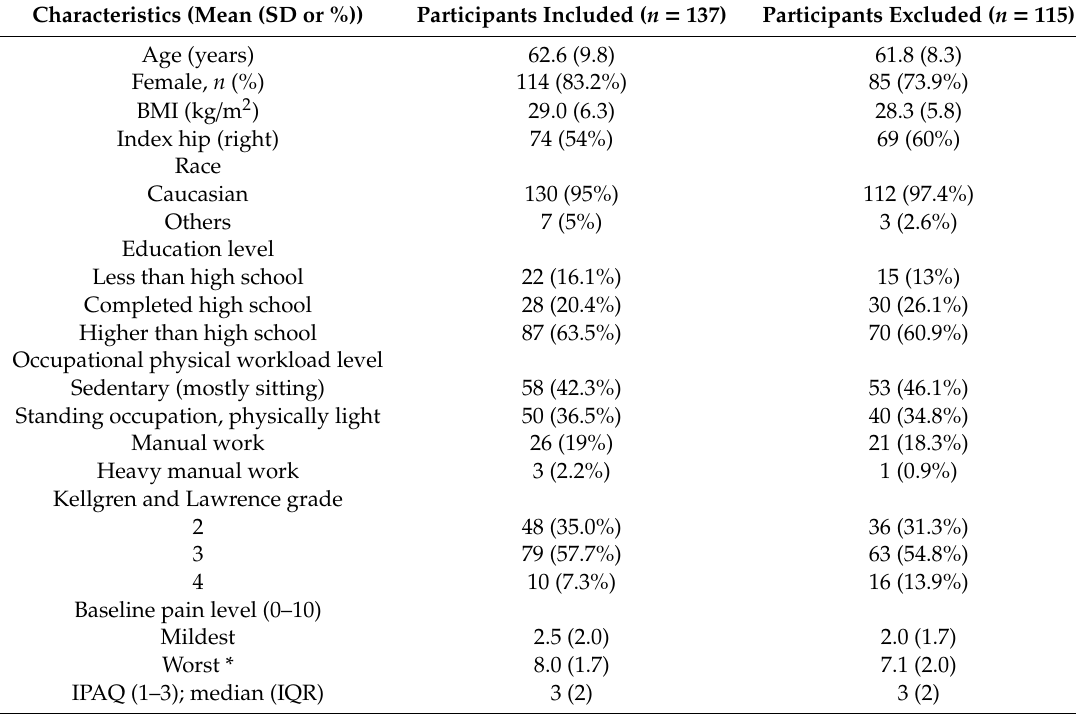
Table 1. Baseline characteristics of participants.